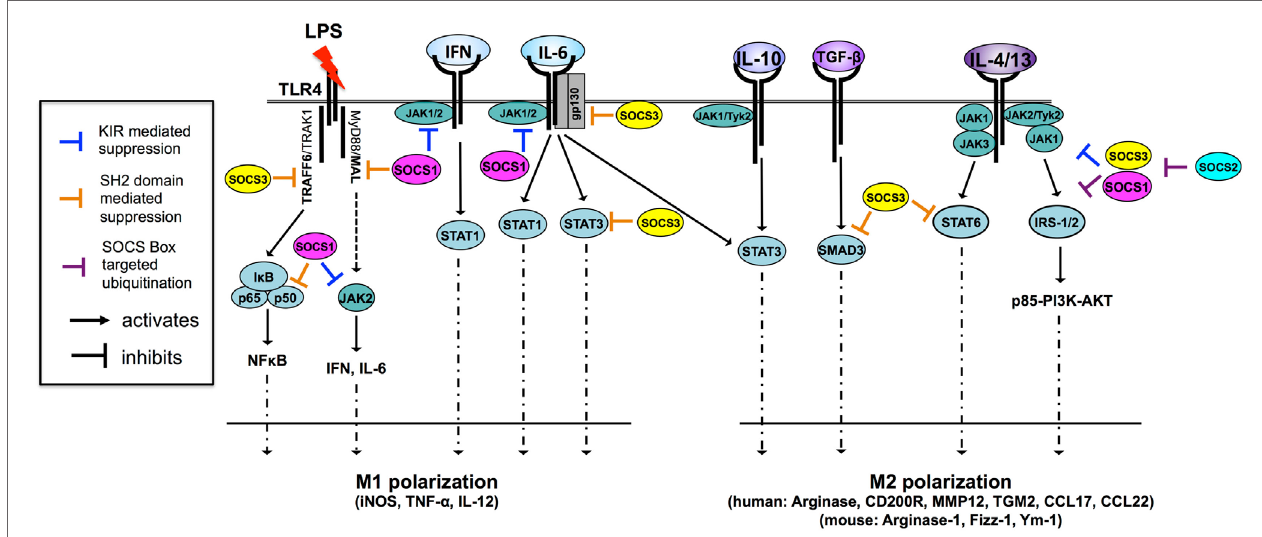
FiGURe 2 | SOCS1 and SOCS3 are potent regulators of cytokine signaling and macrophage polarization through multiple mechanisms [adapted from Ref. (11)] . Macrophages are M1 polarized in response to a number of TLR ligands and cytokines. Both SOCS1 and SOCS3 regulate TLR-4 responsiveness through the inhibition of JAK2, MAL, and NF- κ B in the case of SOCS1 and through the inhibition of TRAF6 in the case of SOCS3. SOCS1 also regulates IFN- and IL-6-driven M1 polarization by inhibiting JAK activity through the KIR pseudosubstrate domain. SOCS3 regulates IL-6-driven M1 polarization by binding of pY759 the IL-6 receptor gp130 subunit and termination of signaling. SOCS3 also binds activated STAT3 to terminate signaling. Paradoxically, SOCS3 does not inhibit IL-10 signaling because it cannot bind the IL-10 receptor, nor does it effectively bind IL-10-activated STAT3, suggesting SOCS3 binding to STAT substrate is a highly specific and the determinants of this interaction are not fully understood. SOCS3 promotes M1 polarization and regulates TGF- β -driven M2 polarization by binding and preventing nuclear translocation of SMAD3. IL-4 and IL-13 trigger two distinct M2-polarizing pathways, the STAT6 and IRS-2 pathways. SOCS3 regulates IL-4/-13-driven STAT6 activation and nuclear translocation while both SOCS1 and SOCS3 can dampen PI3K and AKT activation by targeting IRS signaling proteins for proteasomal degradation. SOCS2 regulates SOCS1 and SOCS3 expression levels through proteasomal degradation. IRS, insulin receptor substrate; JAK, Janus kinase; MAL, MyD88-adaptor-like protein; STAT, signal transducers and activators of transcription; TGF- β , transforming growth factor- β ; TRAF6, TNF-receptor-associated factor